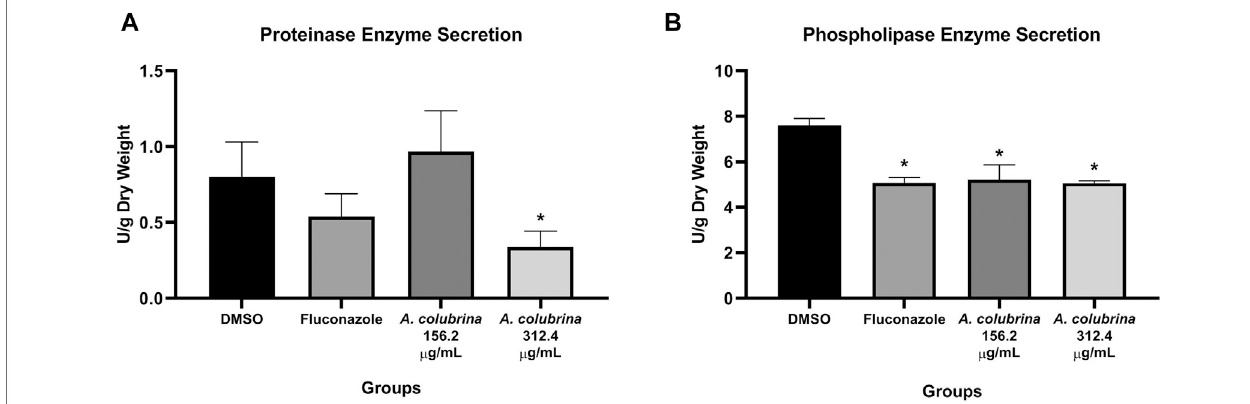
FIGURE 2 | C. albicans MYA 2876 72-hours-bio fi lm proteolytic enzymes secretion expressed in U/grams of dry weight after treatment with A. colubrina extract (312.5 μ g/ml – 20 × 15.62 μ g/ml; 156.2 μ g/ml – 10 × 15.62 μ g/ml). (A) Proteinase activity; (B) Phospholipase activity. DMSO 0.1%: vehicle control; Fluconazole (10 μ g/ ml): positive control. Values shown with asterisk (*) are statistically signi fi cant when compared to the vehicle control ( p < 0.05).